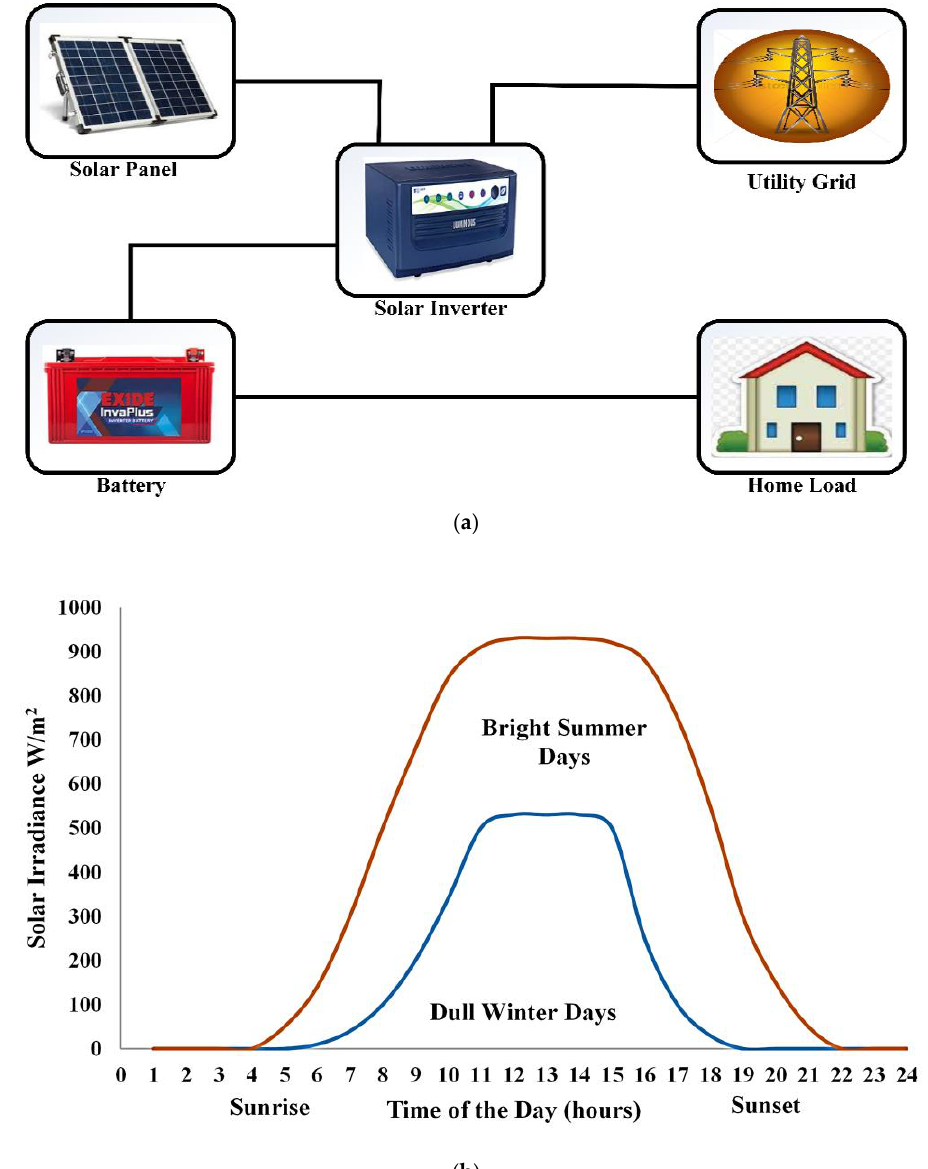
Figure 3. ( a ) The basic diagram of the solar system with inverter [33]; and ( b ) average Solar Irradiance in a day [34].